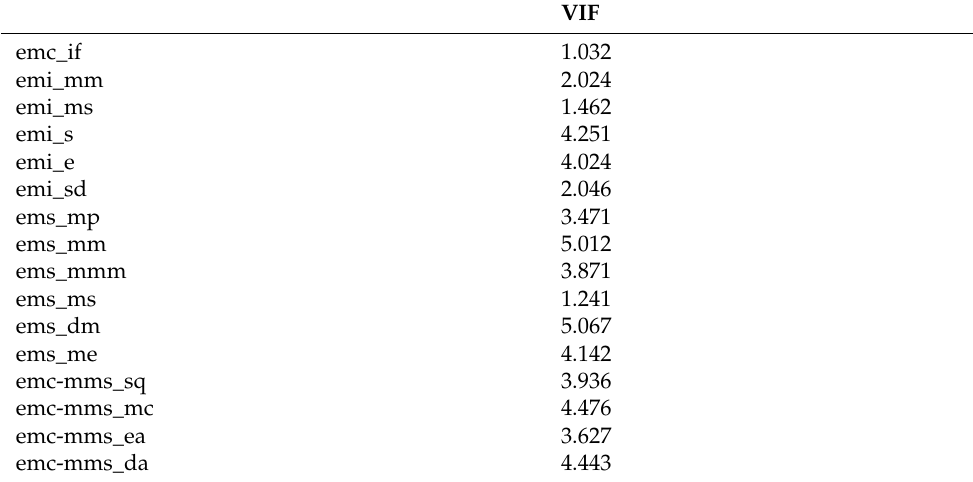
Table A5. Outer VIF